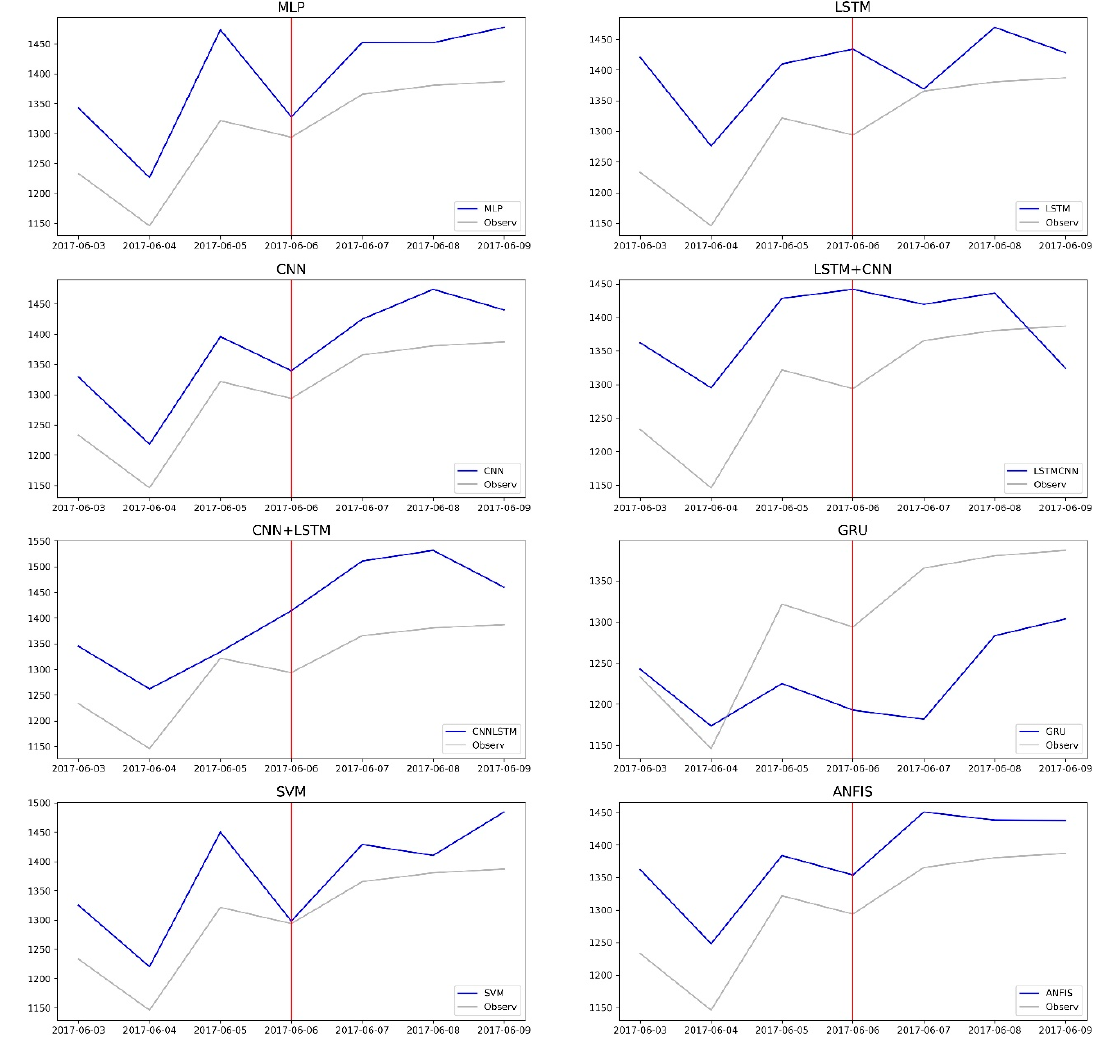
Figure 30. Comparison of special day patterns with different algorithms.